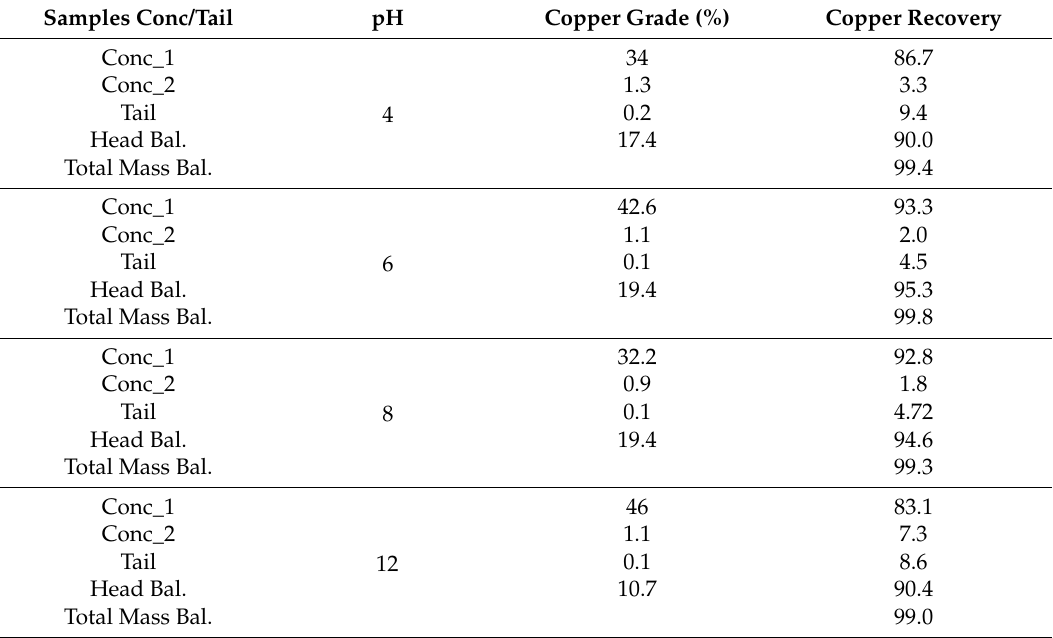
Table 2. The grade and Recovery results with respect to varying pH at collector